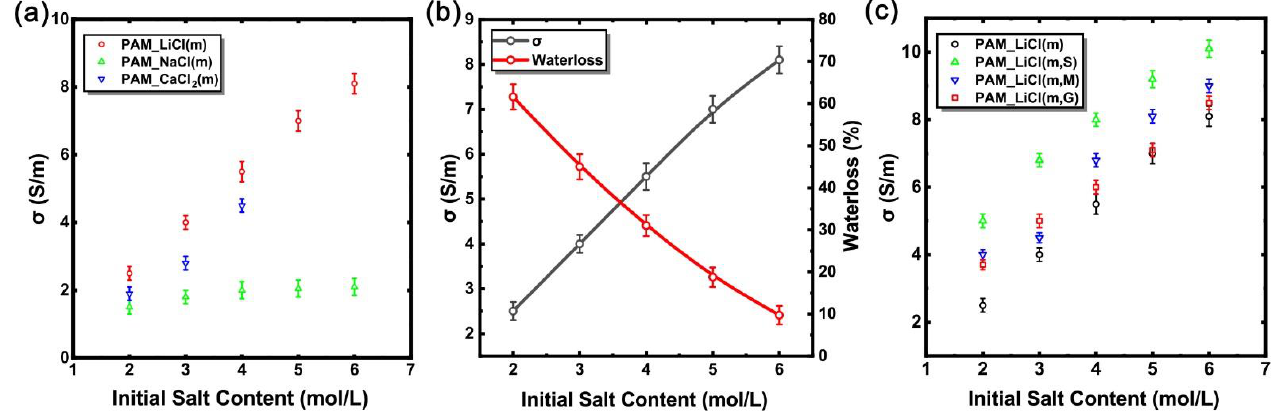
Figure 4. ( a ) The conductivity of steady-state hydrogel samples containing different salts with varied concentration when kept in a chamber at a temperature of 25 °C and a relative humidity of 60% RH; ( b ) changes in steady-state water loss rate and conductivity of PAM_LiCl hydrogels with initial dissolved concentration; ( c ) conductivity of steady-state PAM_LiCl(m, S), PAM_LiCl(m, M), and PAM_LiCl(m, G).